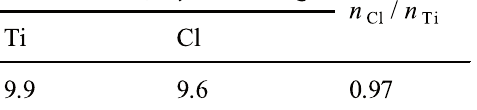
Table 3. Result of analyses of the synthesized